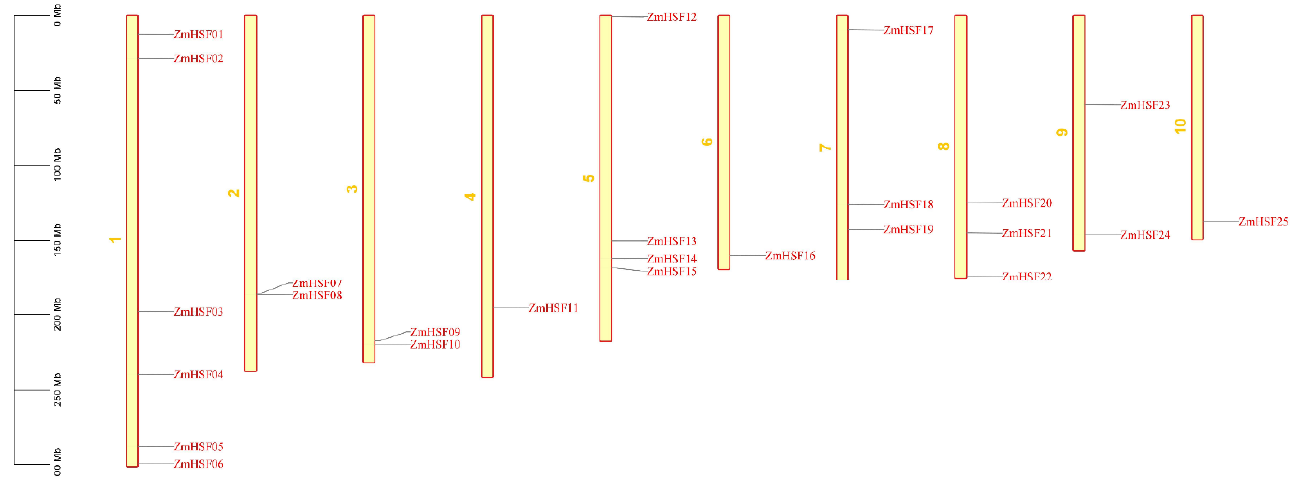
Figure 1. The chromosomal position of HSF genes in maize. The scale on the left side represents megabases (Mb). The chromosome number is indicated at the middle of each bar.